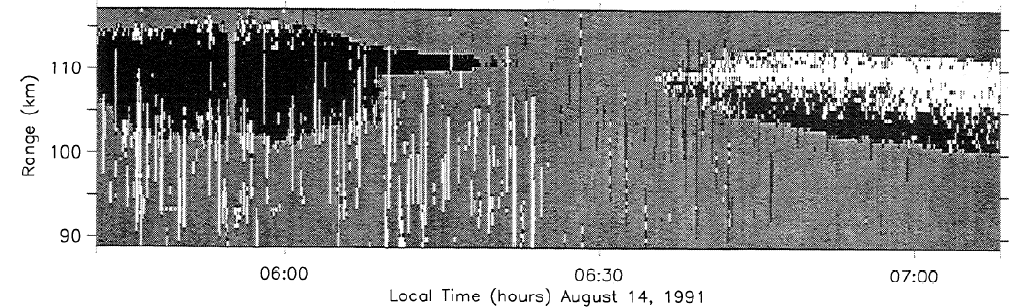
Figure 1 The extreme change of meteor echo occurrence and durations observed before and after dawn (reproduced from Chapin and Kudeki, [1994a]). Over 125 meteor echoes are observed from the start of the image until an abrupt break in meteor reflection occurrence near sunrise at 6:20 LT(after which only ∼ 20 trails are observed).